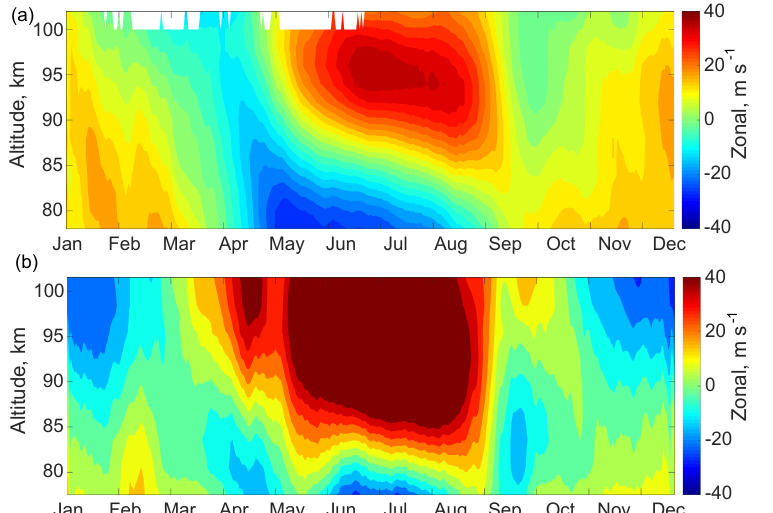
Figure 5. Zonal component of the mean flow observed with meteor radar at Juliusruh (a) and simulated with the KMCM over the same location (b) . White bins in the top panel reflect insufficient statistics of the observed meteor echoes at high